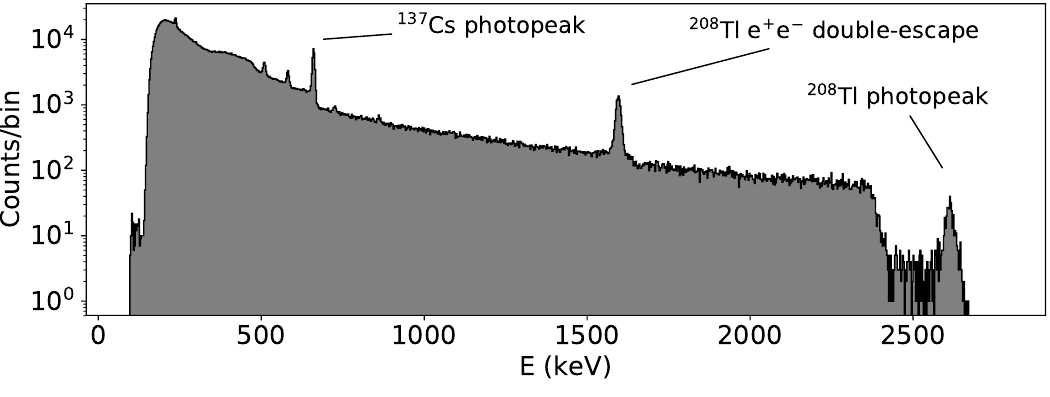
Figure 6 . The full energy spectrum for events with energies greater than approximately 150 keV. Corrections for electron lifetime and geometrical e(cid:11)ects were applied to all events, as well as a correction for the described axial length e(cid:11)ect corresponding to ( m=b ) = 2 : 76 (cid:2) 10 (cid:0) 4 . In addition to the three lines examined in detail in this study, lines are also present due to other gamma rays from the 228 Th decay chain: at 238 keV (from 212 Pb ! 212 Bi decay), 511 keV (e + e (cid:0) annihilation, with some contribution from 208 Tl ! 208 Pb decay), 583 keV ( 208 Tl ! 208 Pb decay), 727 keV ( 212 Bi ! 212 Po decay), and 860 keV ( 208 Tl ! 208 Pb